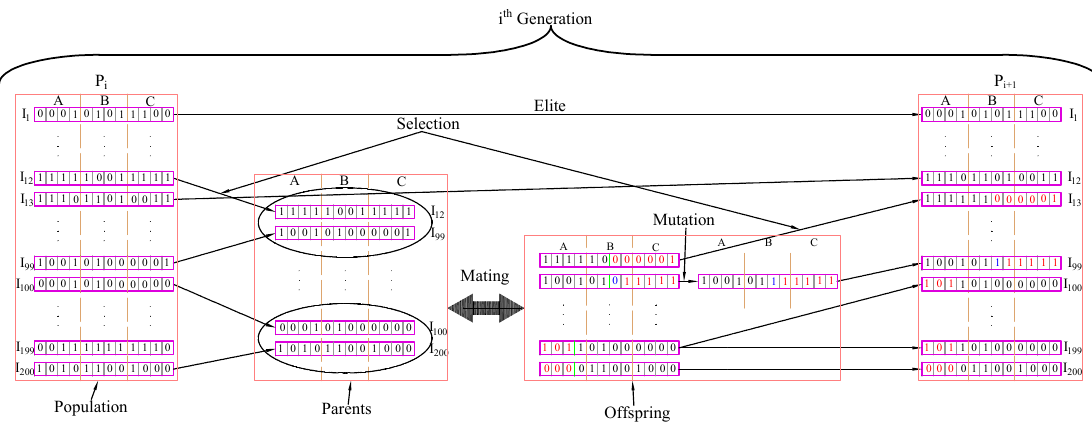
Figure 4. Genetic Algorithm